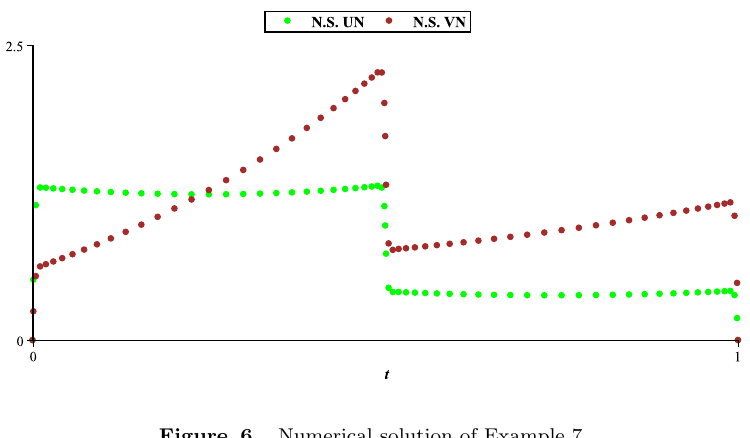
Figure 6. Numerical solution of Example